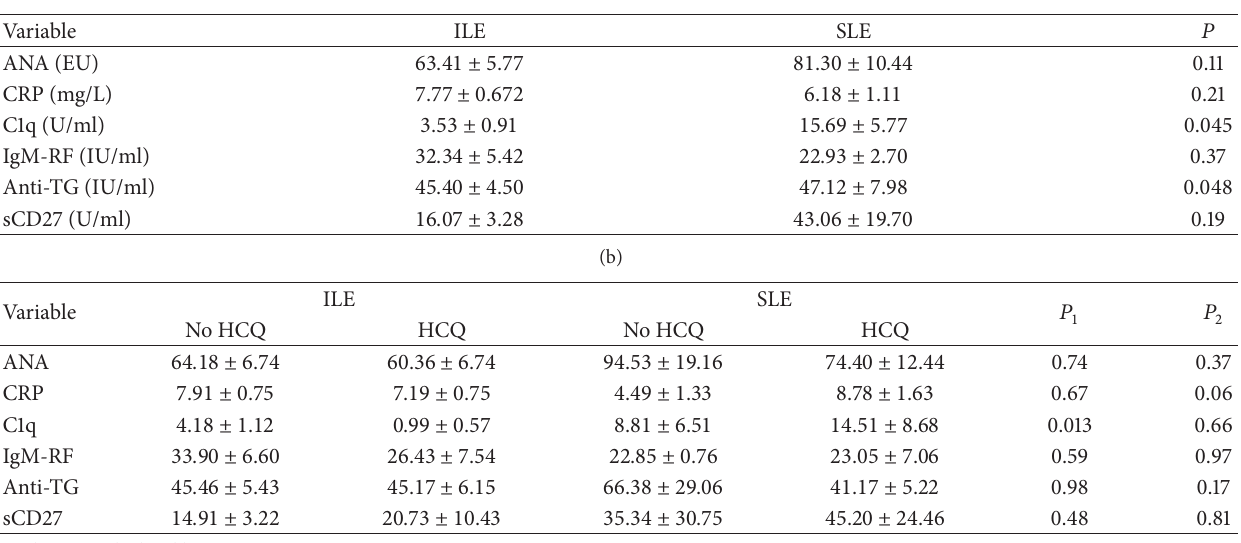
Table 4: Autoantibodies and immunologic measures in ILE and SLE patients.